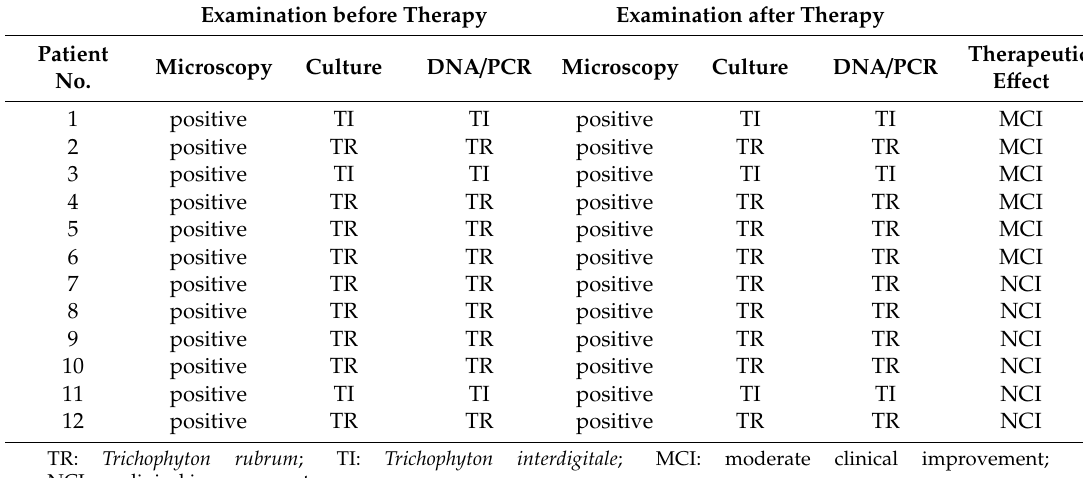
Table 3. Therapeutic e ff ect of nail plate abrasion and refreshment, Protocol